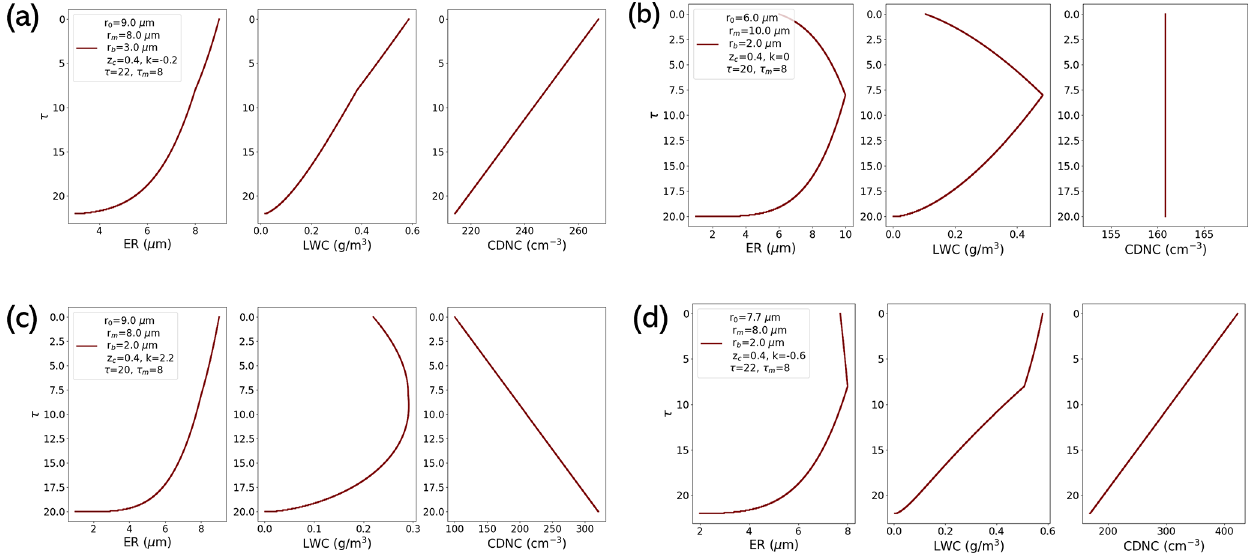
Figure 10. Four cases of cloud ER, LWC, and CDNC profiles generated by the parametrization scheme.